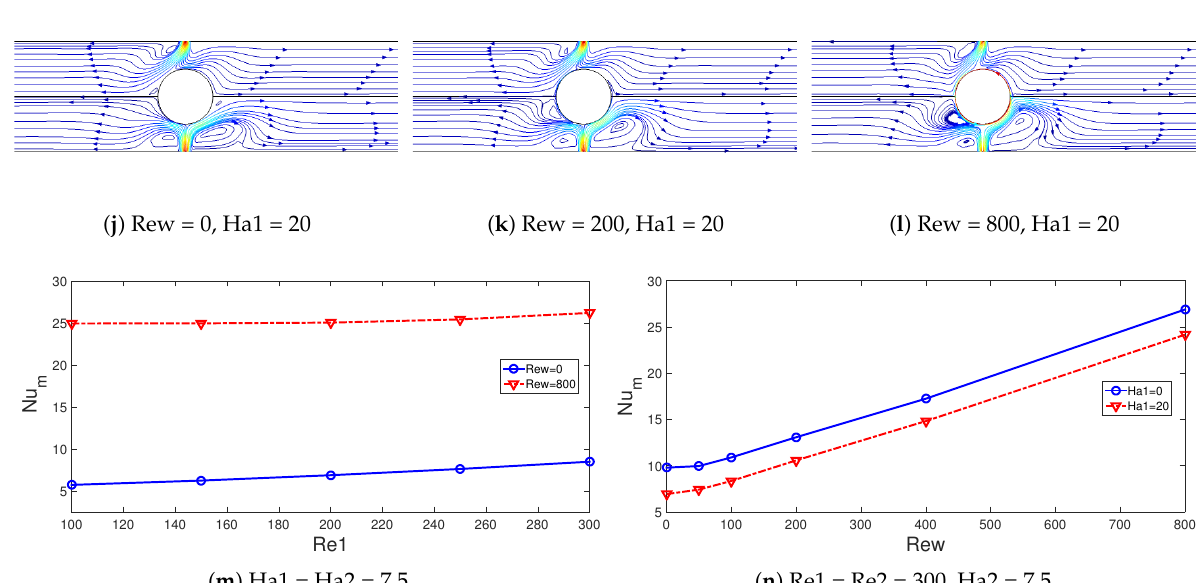
Figure 4. Effects of Re on the streamline variations under the motionless ( a – c ) and rotating ( d – f ) cylinder impacts (Ha1 = 7.5, Ha2 = 7.5, H = 8 w, r = 4 w). Effects of Rew on the streamline variations in the absence ( g – i ) and presence ( j – l ) of upper domain MaF (Re1 = 300, Re2 = 300, Ha2 = 7.5, H = 8 w, r = 4 w); average Nu variations with changes in Re1 ( m ) and Rew ( n ) (H = 8 w, r = 4 w).